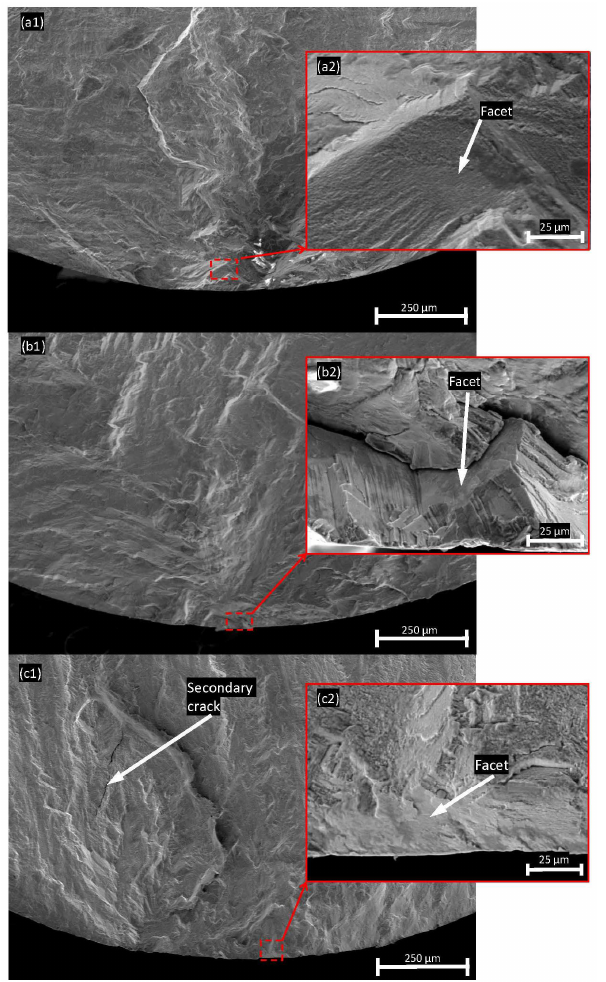
Figure 11. Typical SEM fractographies of fracture surface from E1 sample at ( a1 ) 570 MPa; ( a2 ) facet at near surface region; E2 sample at ( b1 ) 545 MP; ( b2 ) facet at near surface region and ( c1 ) 700 MPa; ( c2 ) facet at near surface region.